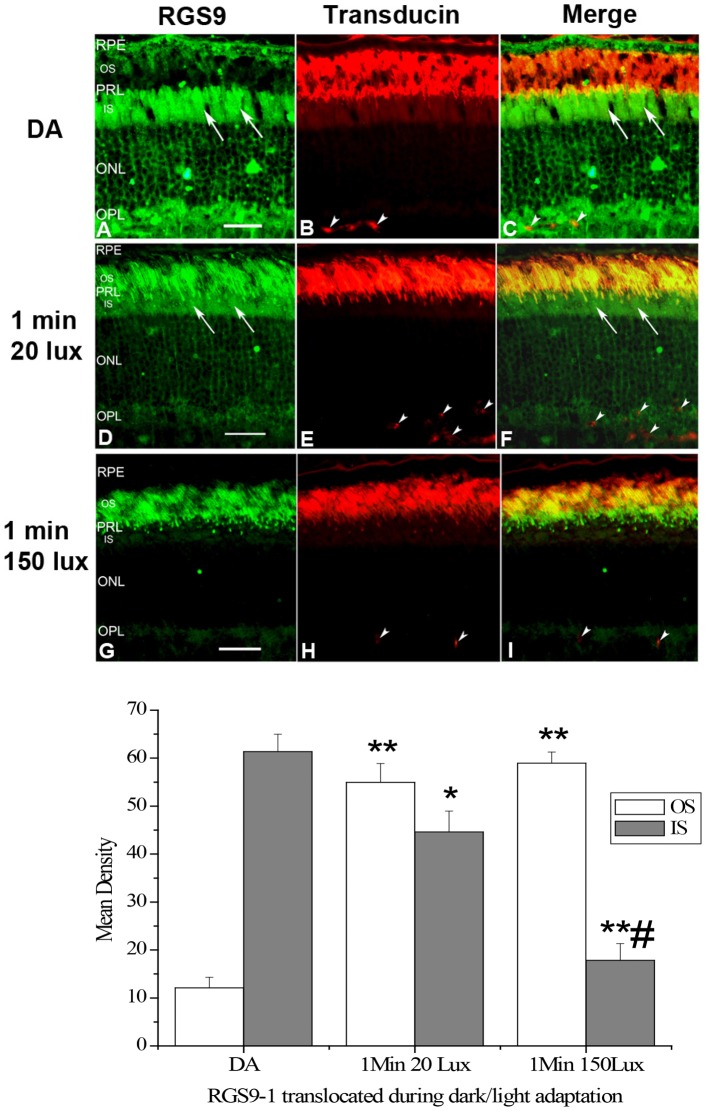
Double labeling studies using anti-RGS9 and anti-Transducin α antibodies confirm that RGS9 is translocated between rod outer segments and inner segments during light/dark adaptation.Upper panel: A–C: Double immunostaining (Merge in C) of RGS9 (A) and Transducin α (B) on a wild type mouse retina after dark adaptation (DA); D–F: Double immunostaining (Merge in F) of RGS9 (D) and Transducin α (E) on a wild type mouse retina after 1 min 20 lux light exposure; G–I: Double immunostaining (Merge in I) of RGS9 (G) and Transducin α (H) on a wild type mouse retina after 1 min 150 lux light exposure. Arrows indicate labeling of RGS9 in the inner segments. Arrow heads indicate non-specifically labeled blood vessels. Other labels are the same as in Fig. 1. Lower panel: Analysis of the average levels of RGS9-1 in the outer segment layer (OS) and inner segment layer (IS); n = 8. *P<0.01,**P<0.001 vs DA; #P<0.001 vs 1 Min 20Lux.